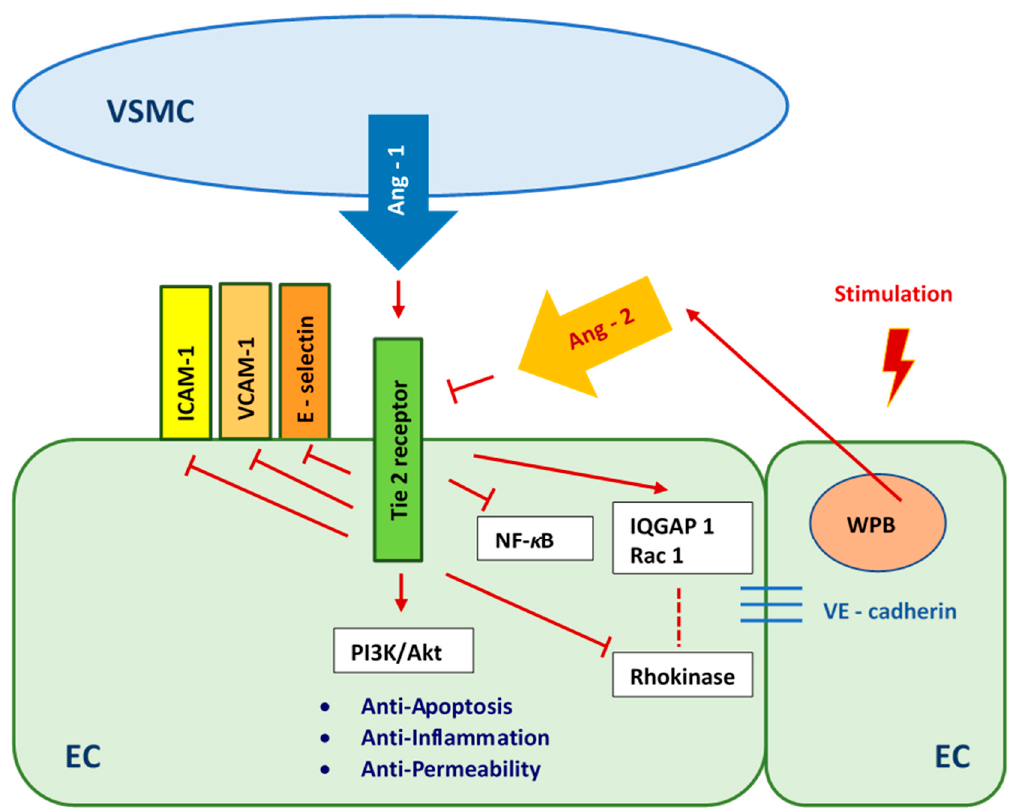
Figure 7. Angiopoietin 1/Tie 2 pathway as a reaction to high- and fluctuating-glucose stimulation. VSMC—Vascular Smooth Muscle Cells, ICAM-1 - Intercellular Adhesion Molecule 1, VCAM-1— Vascular Cell Adhesion Molecule 1, Ang-1— Angiopoietin 1 , Ang-2— Angiopoietin 2 , NF- κ B— Nuclear Factor- κ B, PI3K/Akt—the phosphatidylinositol 3-kinase/protein kinase B pathway, IQGAP1—IQ motif of the GTPase-1 activating protein 1, Rac 1—GTPase Rac1, EC—Endothelial Cell, WPB— Weibel-Palade Body .